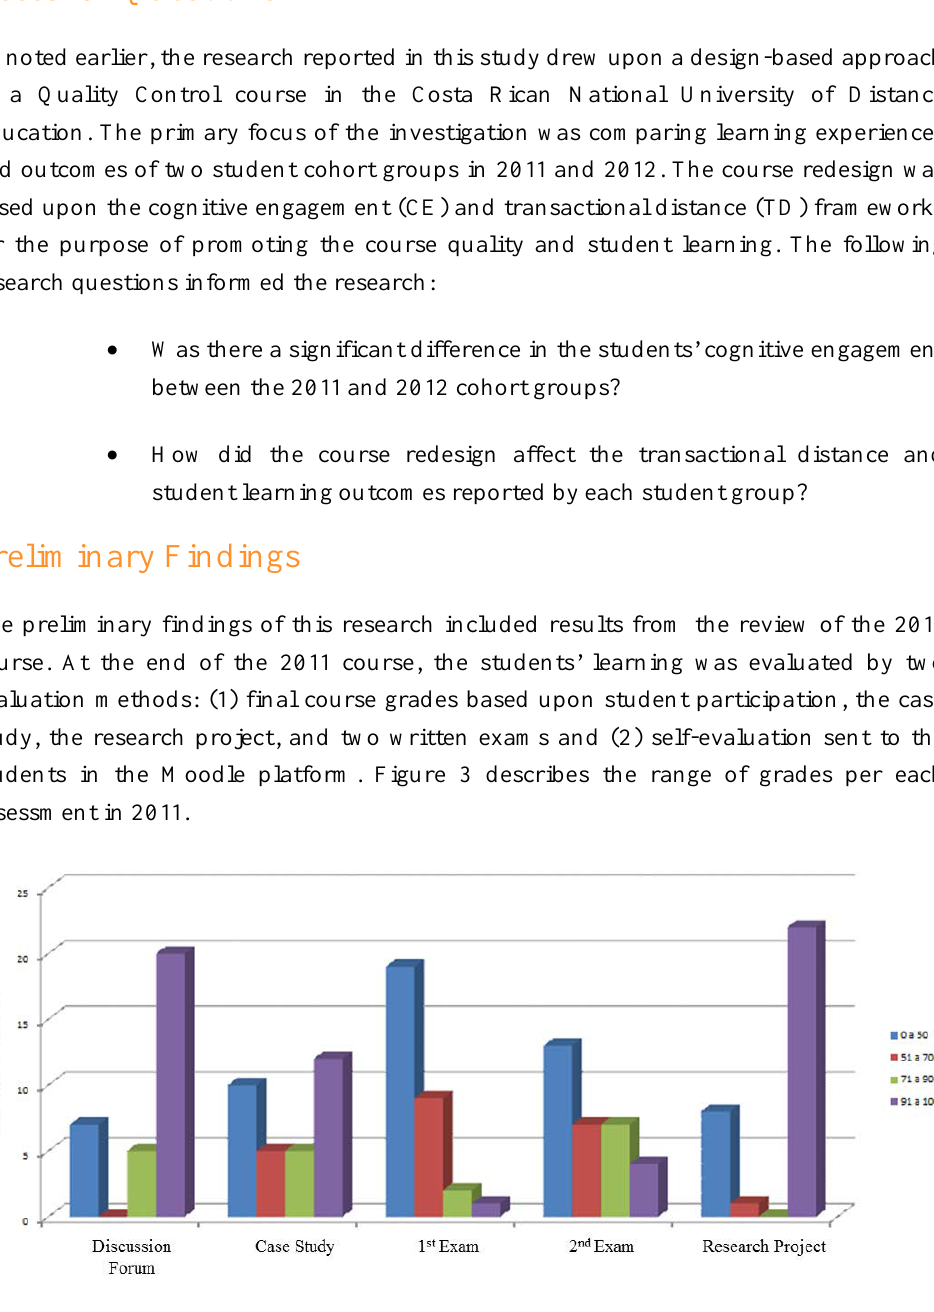
Figure 3 . Range of grades per each assessment in